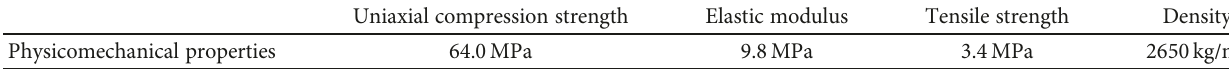
Table 1: Physical and mechanical properties of sandstone.